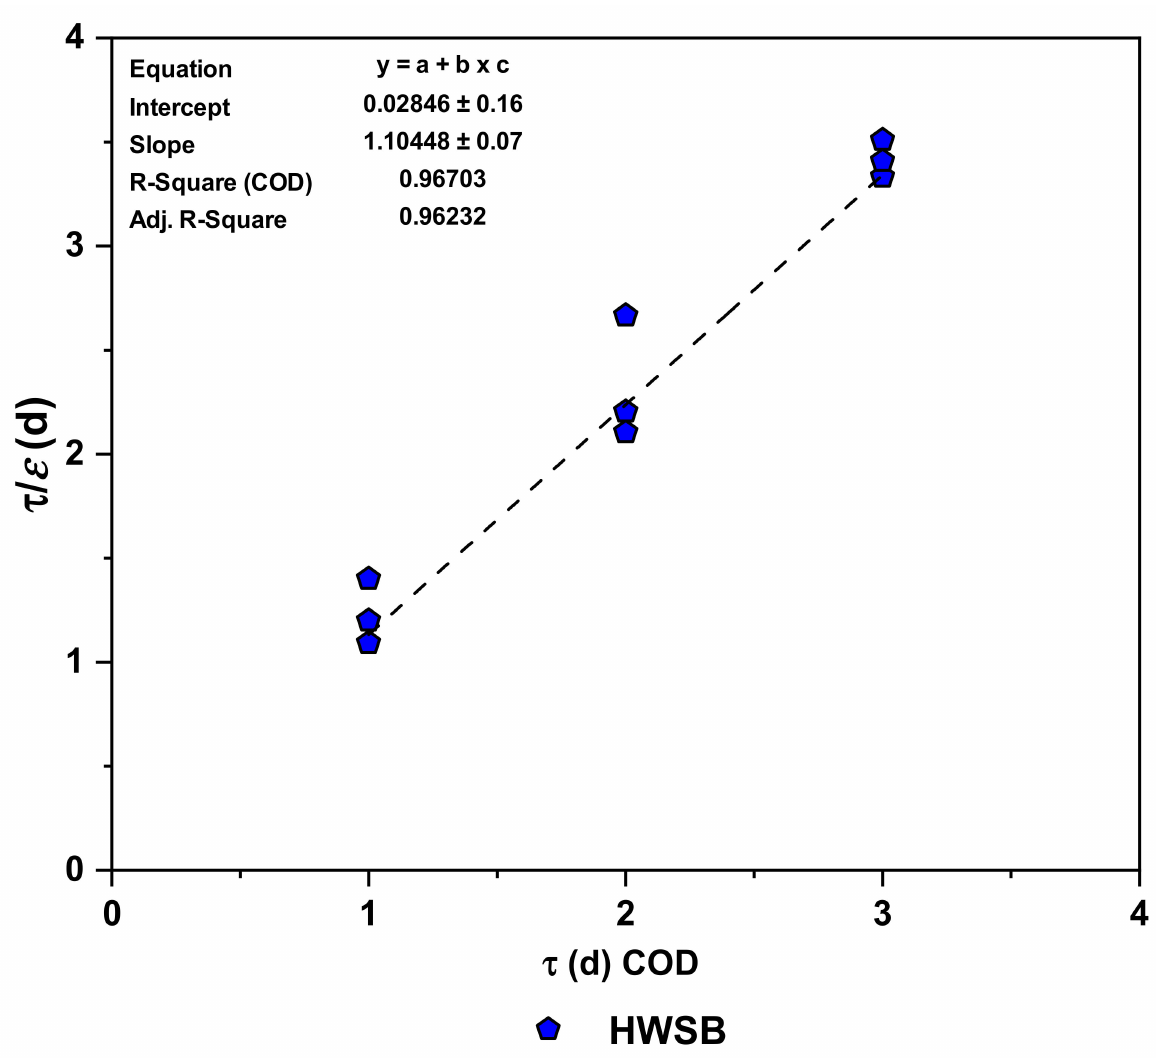
Figure 11. Second-order kinetic plot of COD for